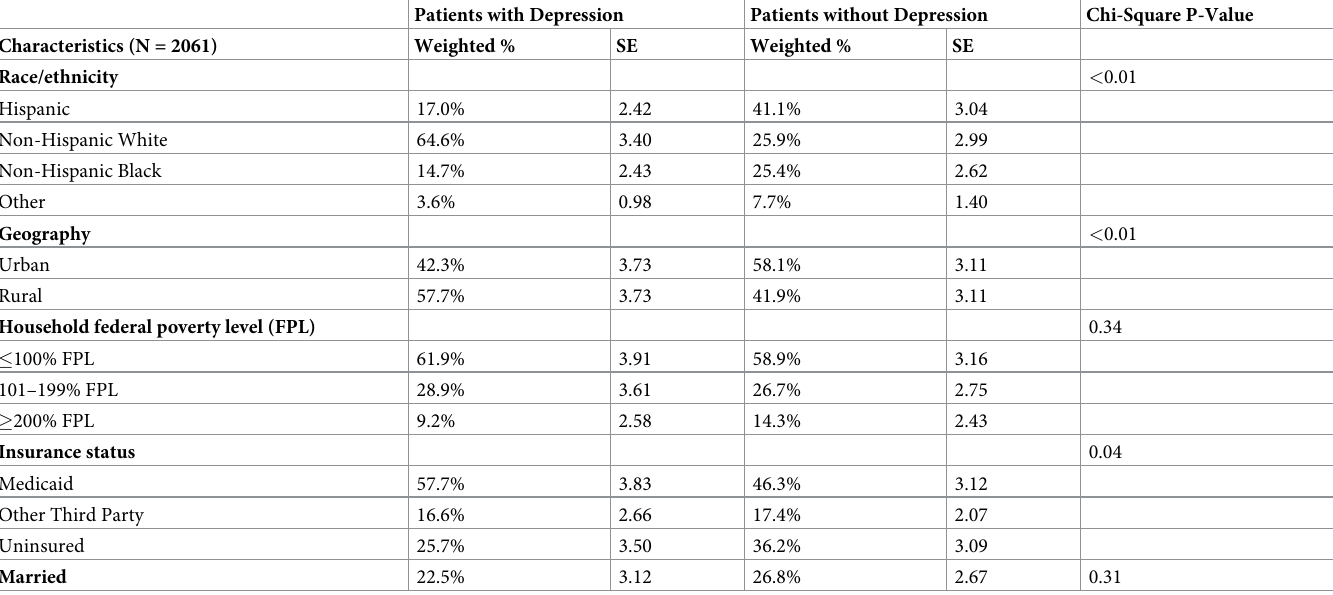
Table 3. Sociodemographic characteristics of female patients with depression of reproductive age (15–49 yrs) served at HRSA funded health centers. Patients with Depression Patients without Depression